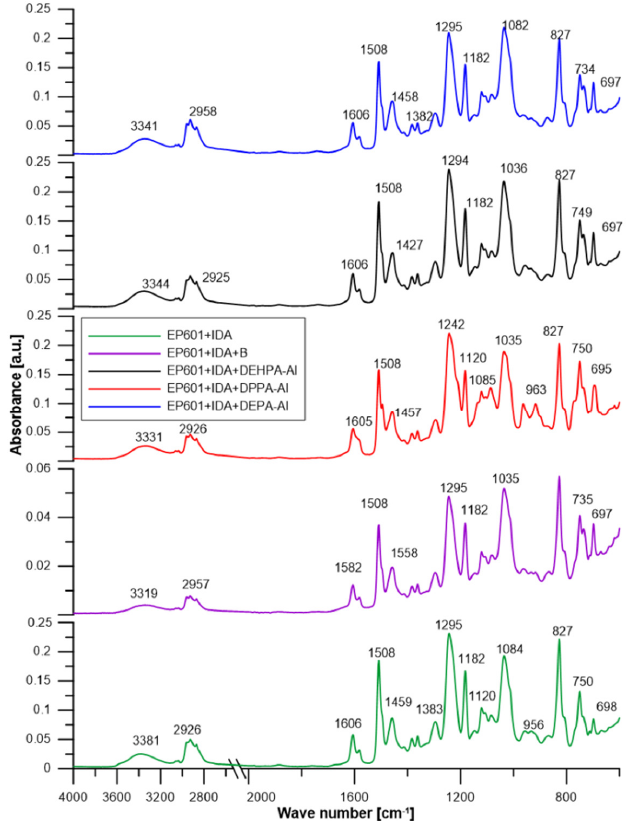
Figure 8. ATR/FT-IR spectra of composites.